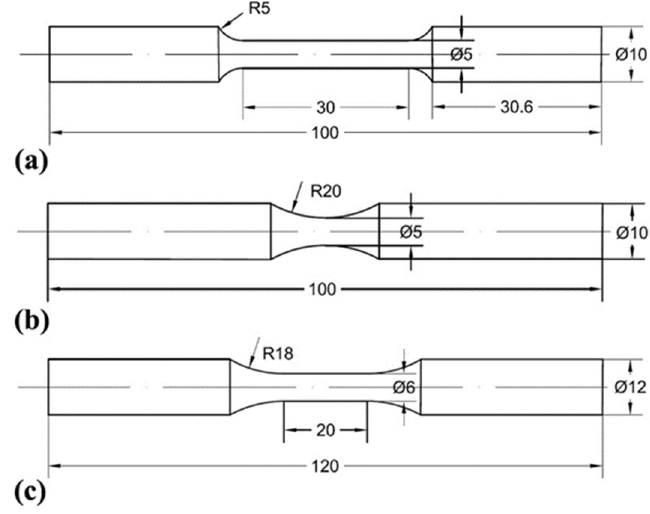
Figure 1. Shape and dimension of specimens (in mm). ( a ) Tensile specimen; ( b ) hourglass specimen, K t = 1.05; ( c ) dogbone specimen.